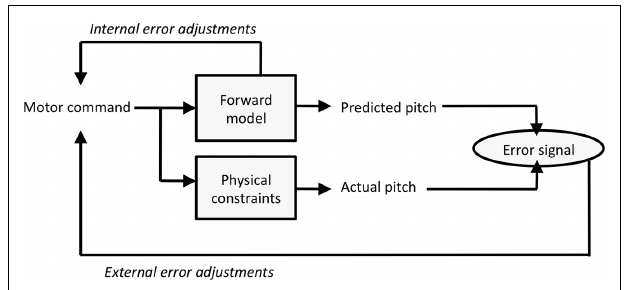
FIGURE 8 |A simplified forward model framework adapted to the present